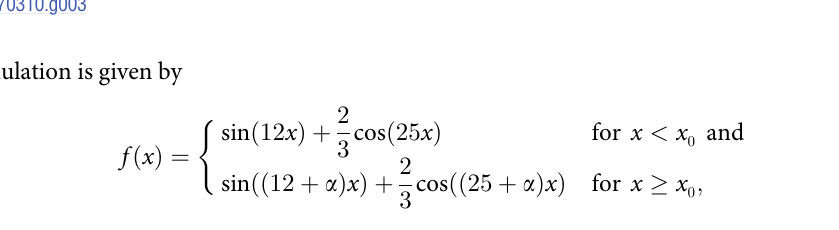
Fig 3. ITS simulation. A . ITS application. Model fit and extrapolation of M shift of α = 4. We find logBF = 0.15. The shaded interval represents two standard deviations around the mean. B . Estimated power spectra. The colors of the power density spectrum correspond to the legend of the regression. C . The RMSE between the estimated and true d ITS using posterior samples of BNDD and an ARMA baseline (dashed line).